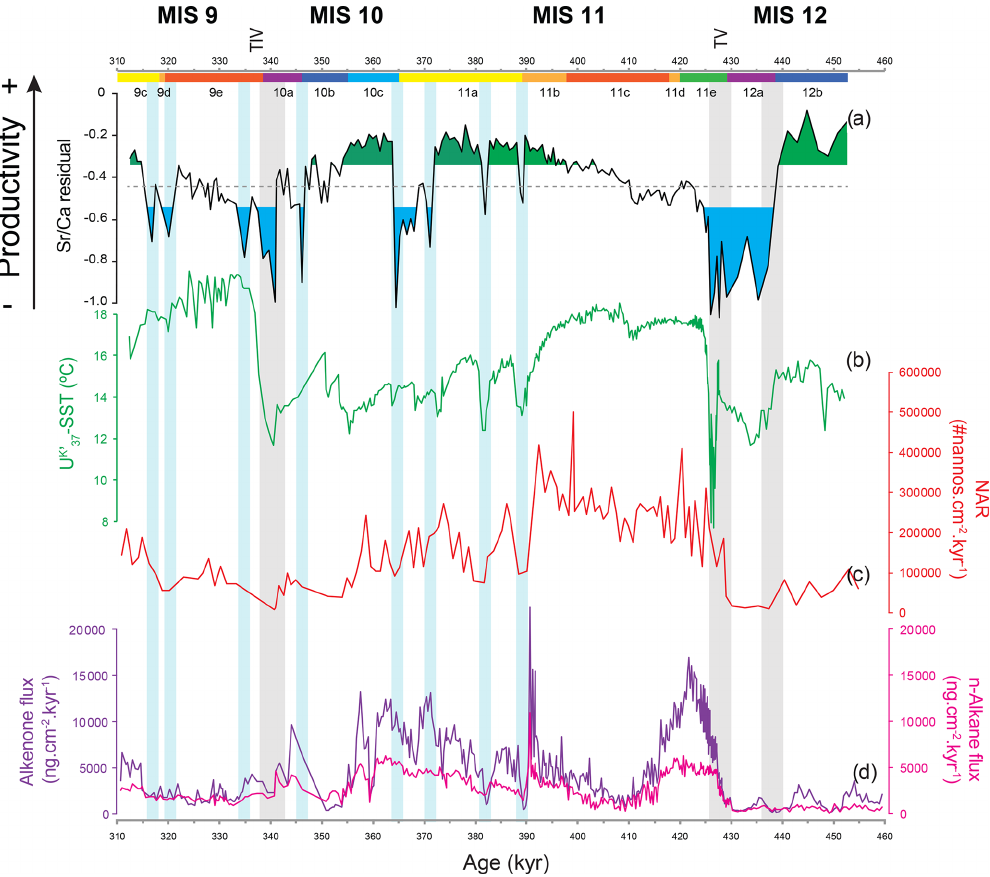
Figure 6. Coccolithophore paleoproductivity reconstruction with “high” and “low” CP levels highlighted in green and blue shading, respec- (cid:48) tively (a) , compared to (b) U k -based reconstruction of sea surface temperature (Rodrigues et al., 2011), (c) nannofossil accumulation rate 37 (NAR) (Amore et al., 2012), and (d) total alkenone (AlkAR) and n -alkane accumulation rates (Rodrigues et al., 2011). Chronology as in Fig. 3. Vertical bars: grey bars correspond to Heinrich-type events (HtEs) and blue bars to short-lived events of decreased